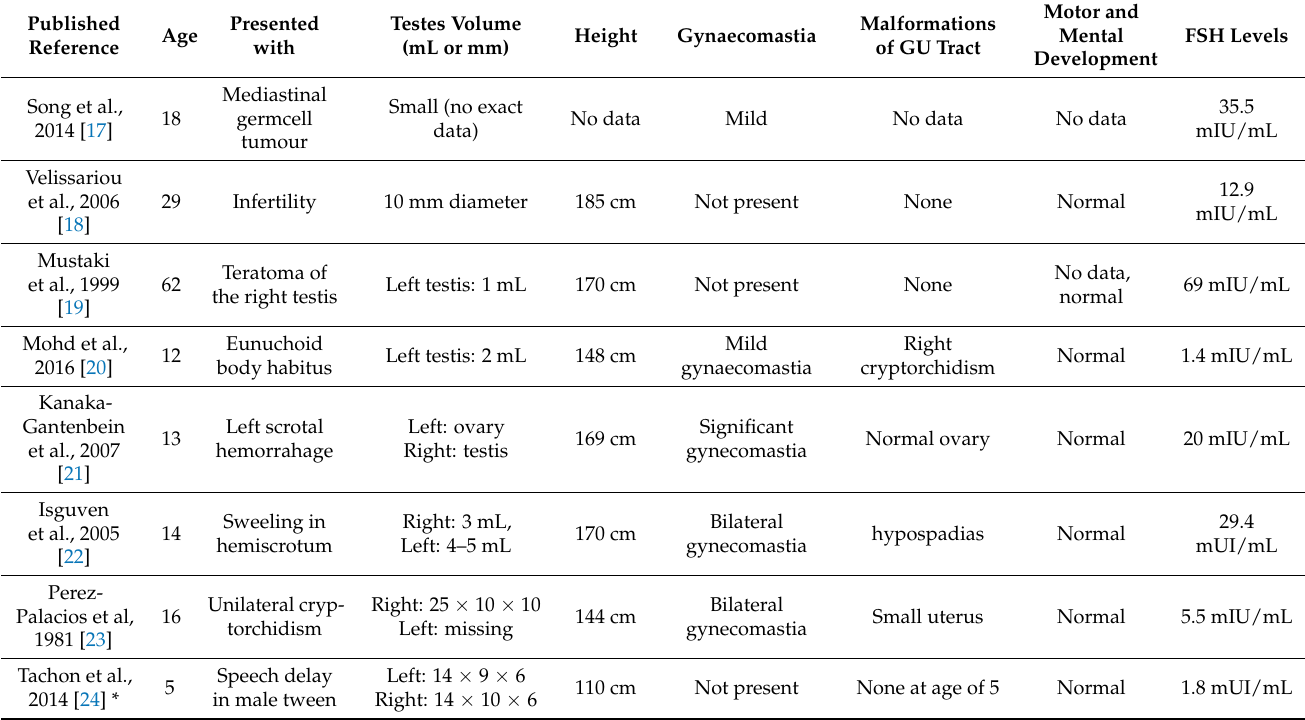
Table 1. Clinical characteristics of published cases of phenotypic males with 47,XXY/46,XX mo-